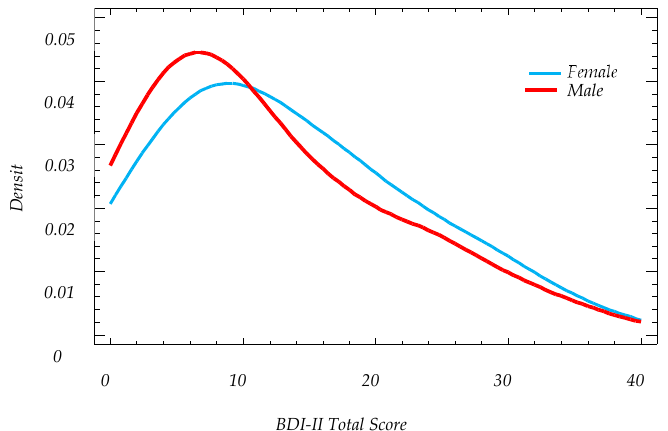
Figure 3. Smoothed density plot of BDI-II scores by gender.